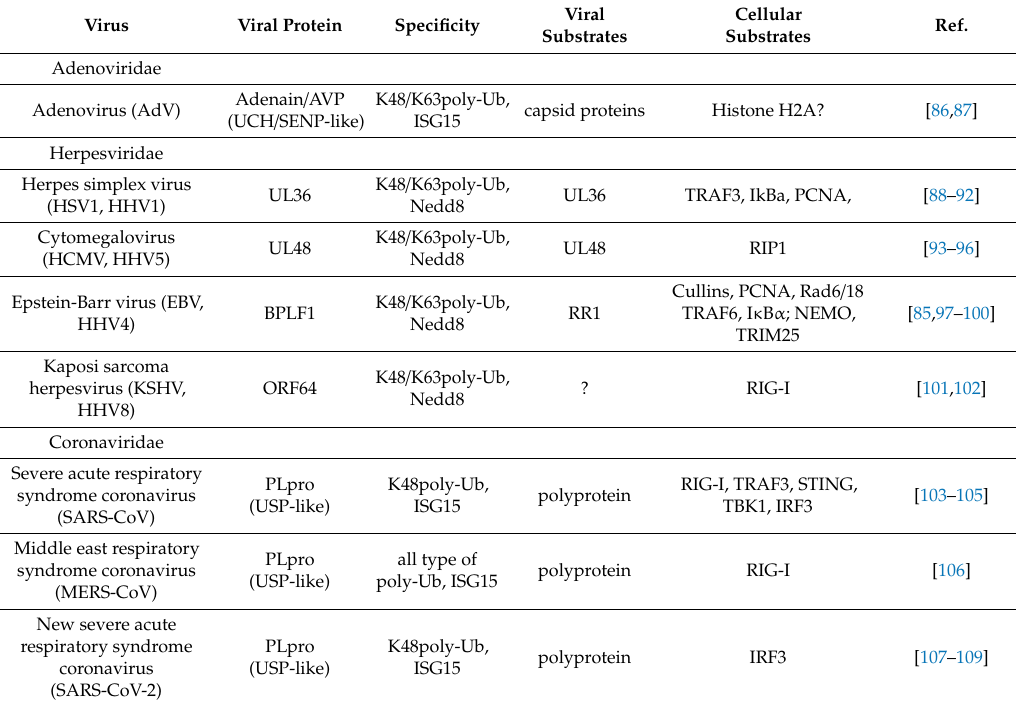
Table 1. UbL deconjugases encoded by human